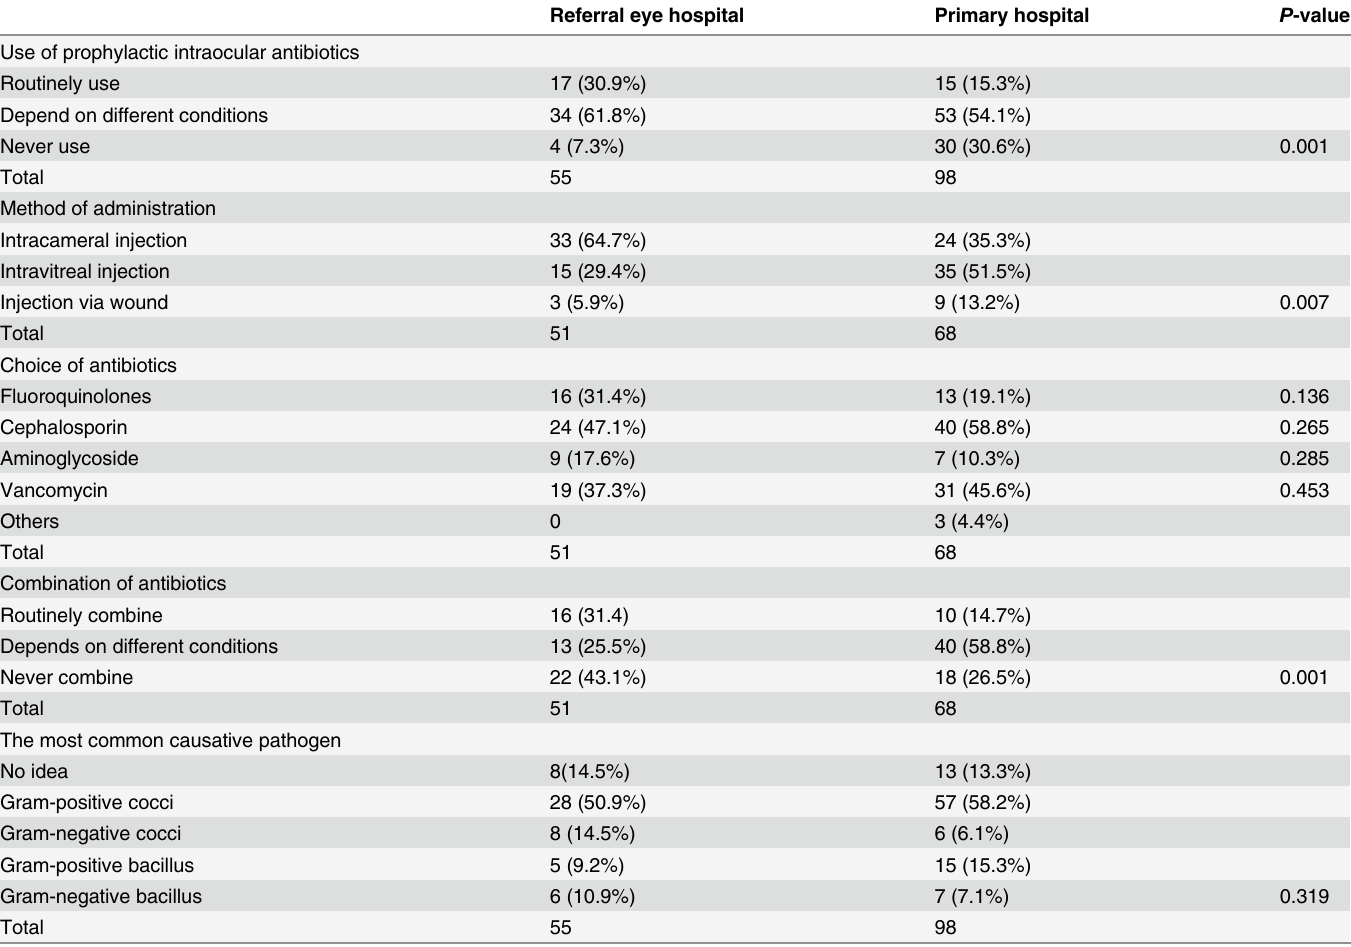
Table 6. Practice of intraocular antibiotics in open globe injuries and hospital type.